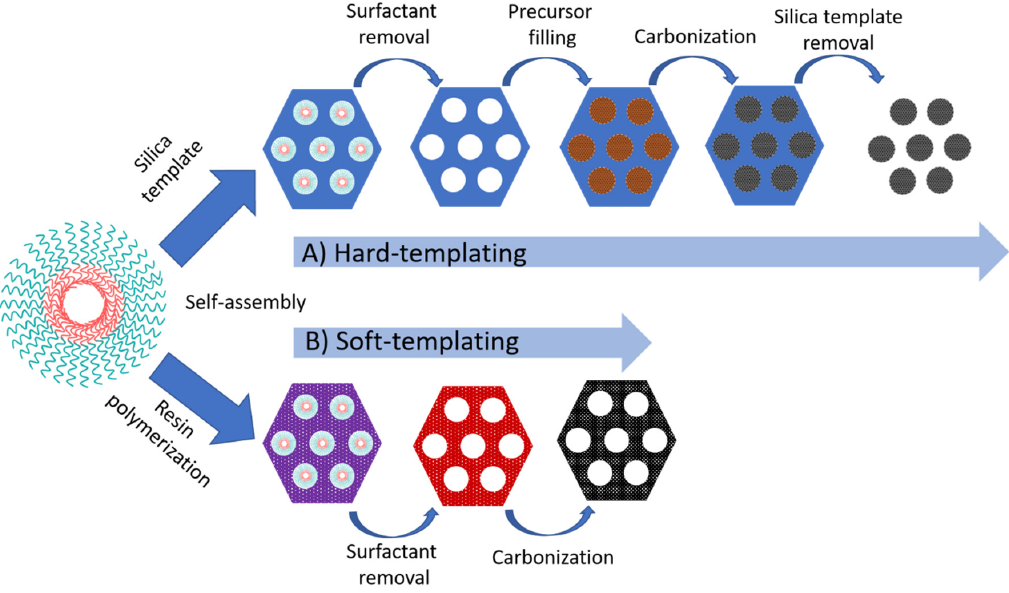
Figure 2. Two typical methods for the preparation of ordered mesoporous carbon materials: ( A ) the nanocasting strategy from mesoporous silica hard templates and ( B ) the direct synthesis from block copolymer soft templates. Adapted from [95] .